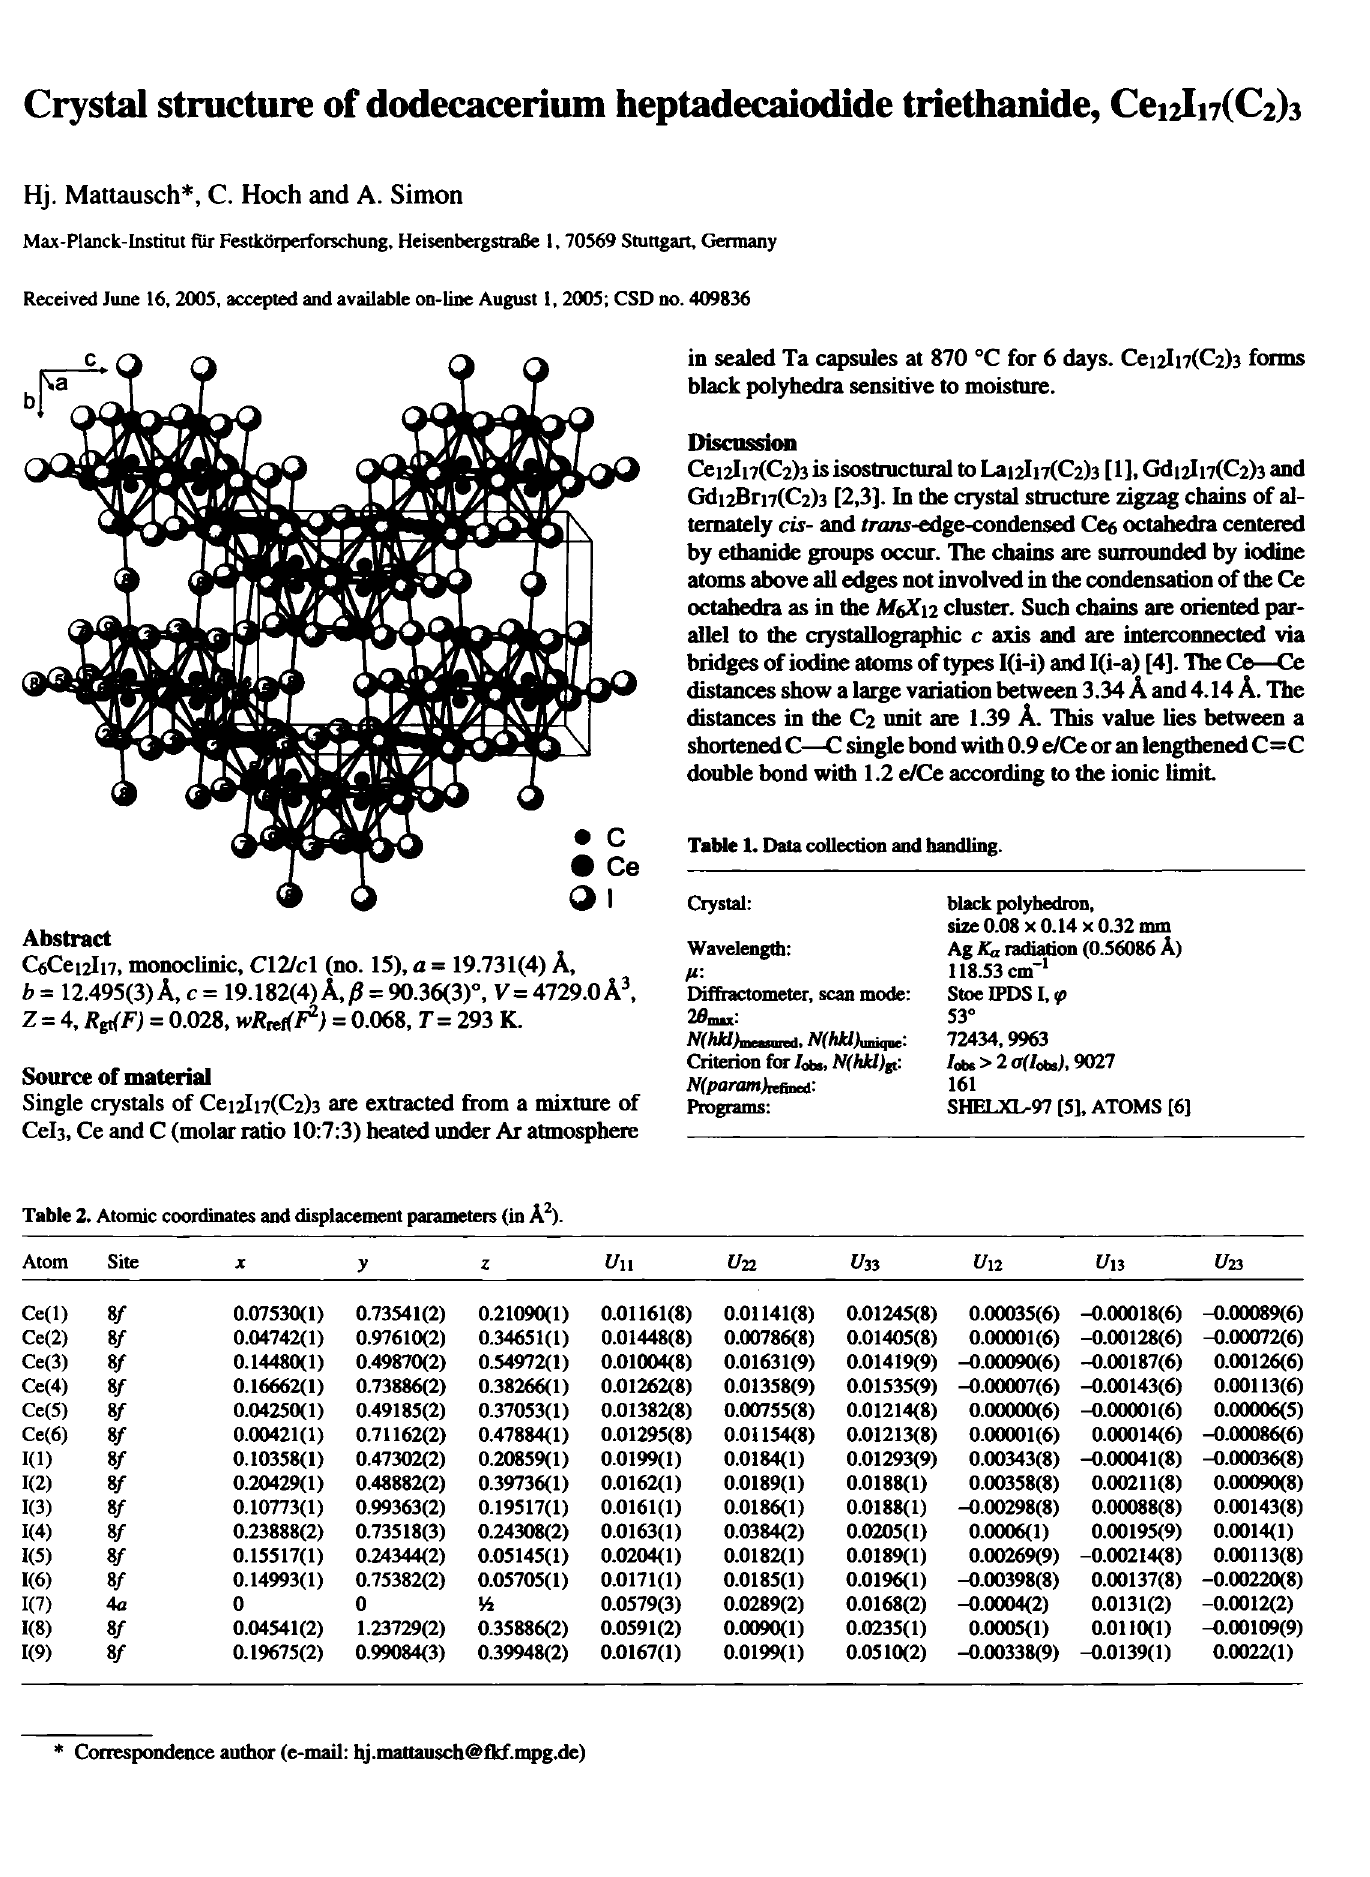
Table 2. Atomic coordinates and displacement parameters (in A 2